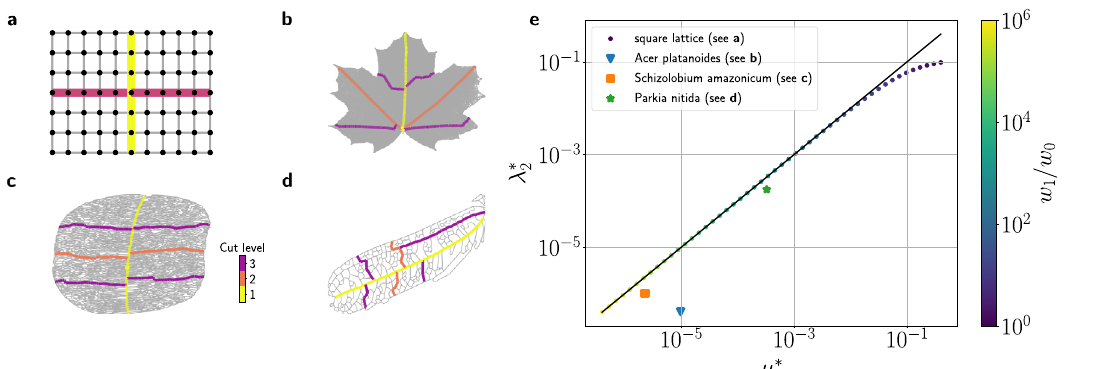
Fig. 4 | Algebraic and Topological Connectivity in the dual graph of synthetic and real-world networks. a A square lattice with a tunable dual community structure. The edge weights along the central vein w 1 are stronger than the weights w 0 of the remaining edges. The ratio w 1 / w 0 can be tuned to test the relation of algebraic and topological connectivity given by Eq. (12). b – d Hierarchical organization in leaf venation networks of three different spe- cies revealed by repeated graph bisection of the dual graph. The dual